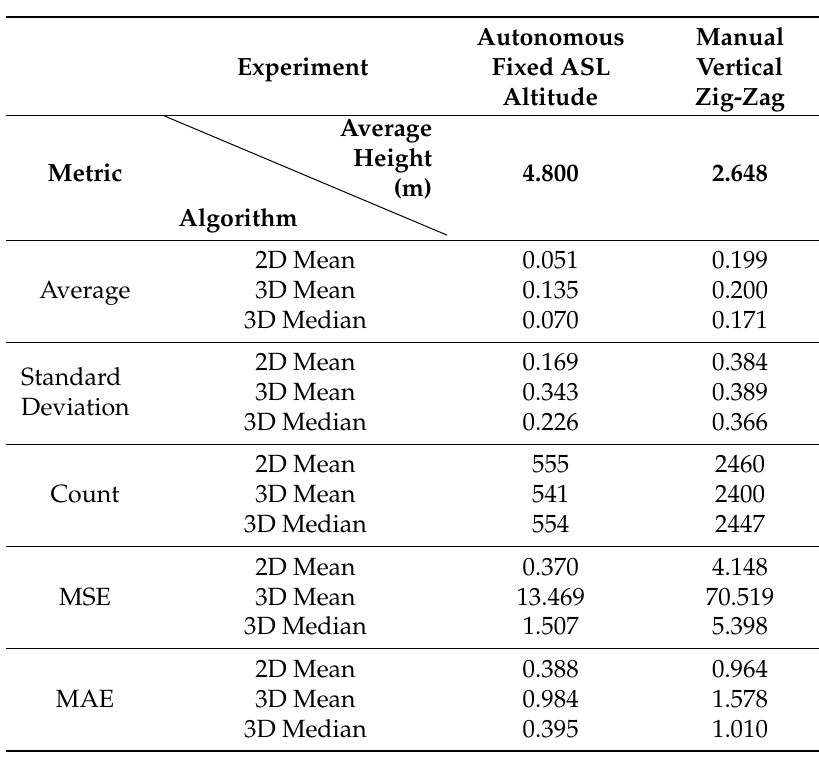
Table 1. Quantitative results of the classifier filtered data. The first row represents the experiments; the first column the metrics used; the second row contains the average height, in meters, computed exclusively with the LIDAR (LIght Detecting and Ranging) data, of each experiment; the second column contains the evaluated algorithms. In addition to the classifier filter, for the averages and standard deviations, we filtered the errors up to 250% and represented the results in relative numbers. The MSE (Mean Squared Error) and MAE (Mean Absolute Error) are based on absolute numbers, filtered only by the